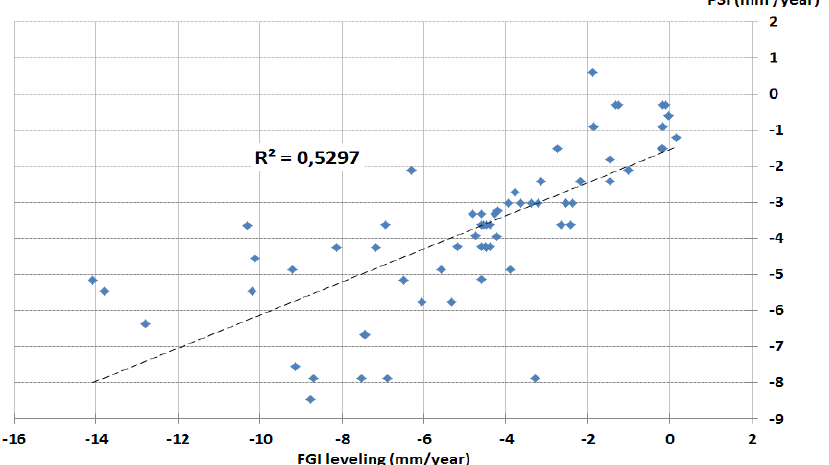
Figure 8. The PS subsidence compared to the FGI precise leveling